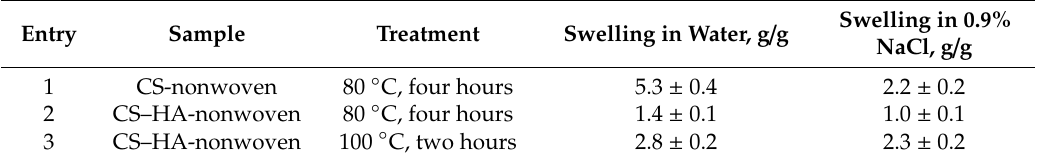
Table 1. Swelling of nonwoven materials, mean ± standard deviation (n = 3).